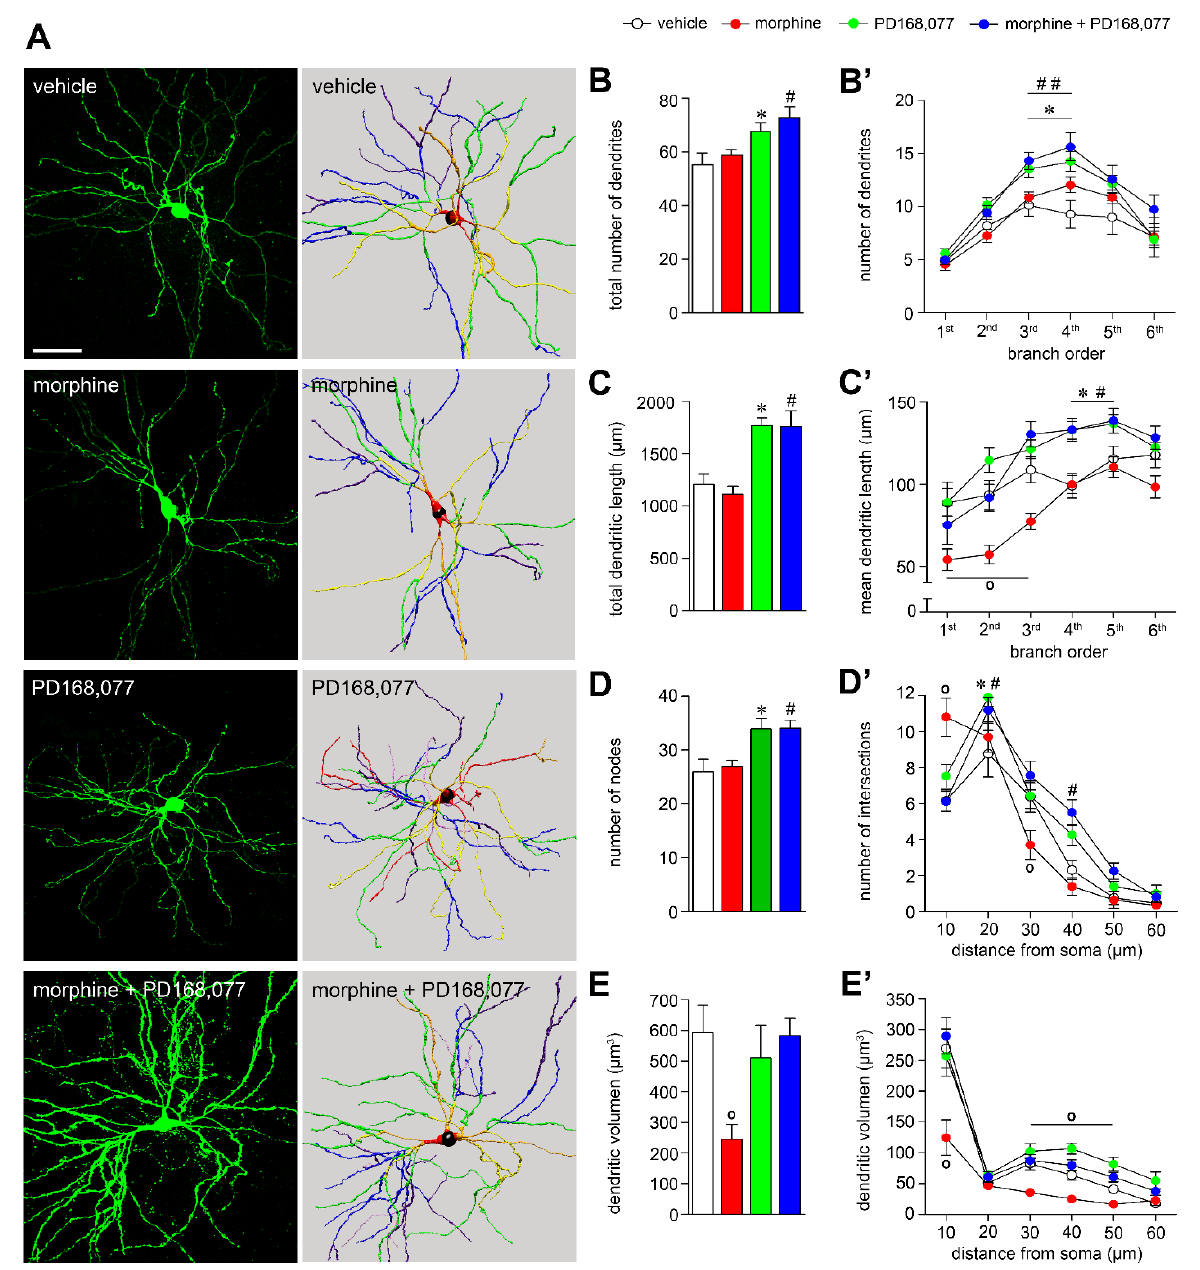
Figure 1. Changes in striatal MSNs dendritic arbor complexity after continuous administration of morphine and/or PD168,077. ( A ) Representative striatal MSNs confocal images (left panels) and reconstructions (right panels) demonstrating the effect of continuous treatment (14 days) with vehicle, morphine (20 mg/kg/d), PD168,077 (1 mg/kg/d) and morphine + PD168,077 (20 mg/kg/d and 1 mg/kg/d). Dendritic branch order is coded by: red, 1st; orange, 2nd; yellow, 3rd; green, 4th; blue, 5th; purple, 6th; pink, 7th. ( B ) Total number and ( B’ ) number of dendrites as a function of dendritic branch order. ( C ) Total dendritic length ( µ m) and ( C’ ) dendritic length as a function of dendritic branch order. ( D ) Number of nodes and ( D’ ) number of Sholl intersections along the dendritic arbor. ( E ) Total dendritic volume ( µ m 3 ) and ( E’ ) Sholl analysis of dendritic volume along the dendritic arbor. Data displayed as mean ± SEM, n = 23 neurons on average per treatment. ◦ p < 0.05 vehicle vs. morphine; * p < 0.05 vehicle vs. PD168,077; # p < 0.05, ## p < 0.01 vehicle vs. morphine + PD168,077; one-way ANOVA followed by Tukey test (B,B’) or Kruskal-Wallis test followed by Dunn’s method (C,C’,D,D’,E,E’). Scale bar is 50 µ